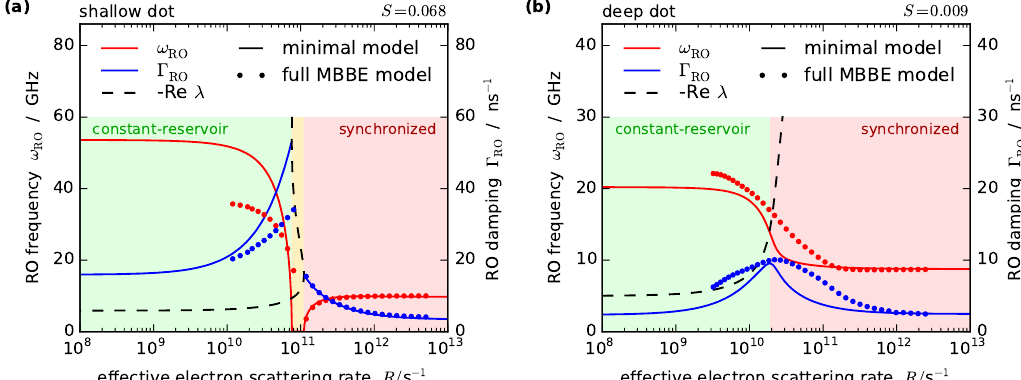
= | Im λ | (solid red) and damping Figure 1. Relaxation oscillation (RO) frequency ω RO = − Re λ (solid blue) determined from Equation (7) for the ( a ) shallow and ( b ) rate Γ RO deep quantum-dot (QD) laser as a function of the effective electron scattering rate R , for constant photon number S . The dashed black line denotes purely real eigenvalues which are not related to ROs. The circles denote the RO parameters extracted numerically from the full microscopically based balance equation (MBBE) model [19]. The green, yellow, and red shaded areas denote the constant-reservoir, overdamped, and synchronized regimes, = 2 ns, g = 230 ns − 1 , κ = 50 ns − 1 . (a) T = 0 . 17 ns, S = 0 . 068 , respectively. T sp 1 d = 0 . 035 ; (b) T = 0 . 2 ns, S = 0 . 009 , d = 0 . 25 1